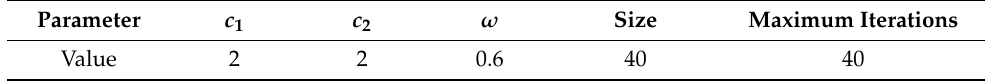
Table 1. Parameters of PSO and CPSO.